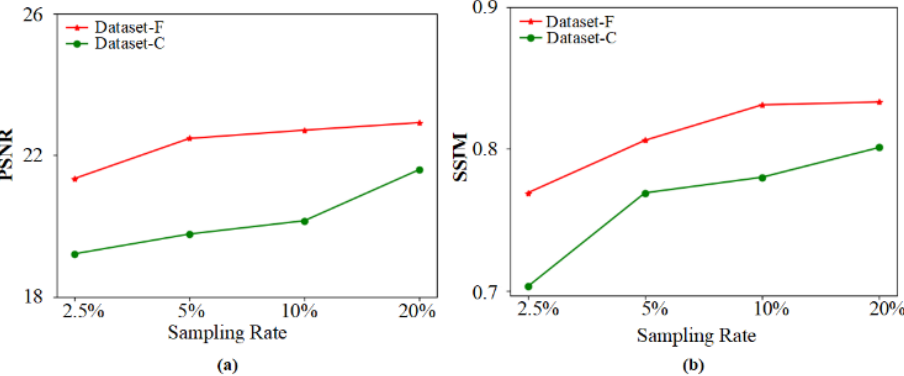
Figure 9. The PSNRs and SSIMs of the reconstructed submarine images of UGI-GAN trained with dataset-F and dataset-C at different sampling rates. ( a ) PSNRs of the reconstructed submarine images of UGI-GAN; ( b ) SSIMs of the reconstructed submarine images of UGI-GAN.